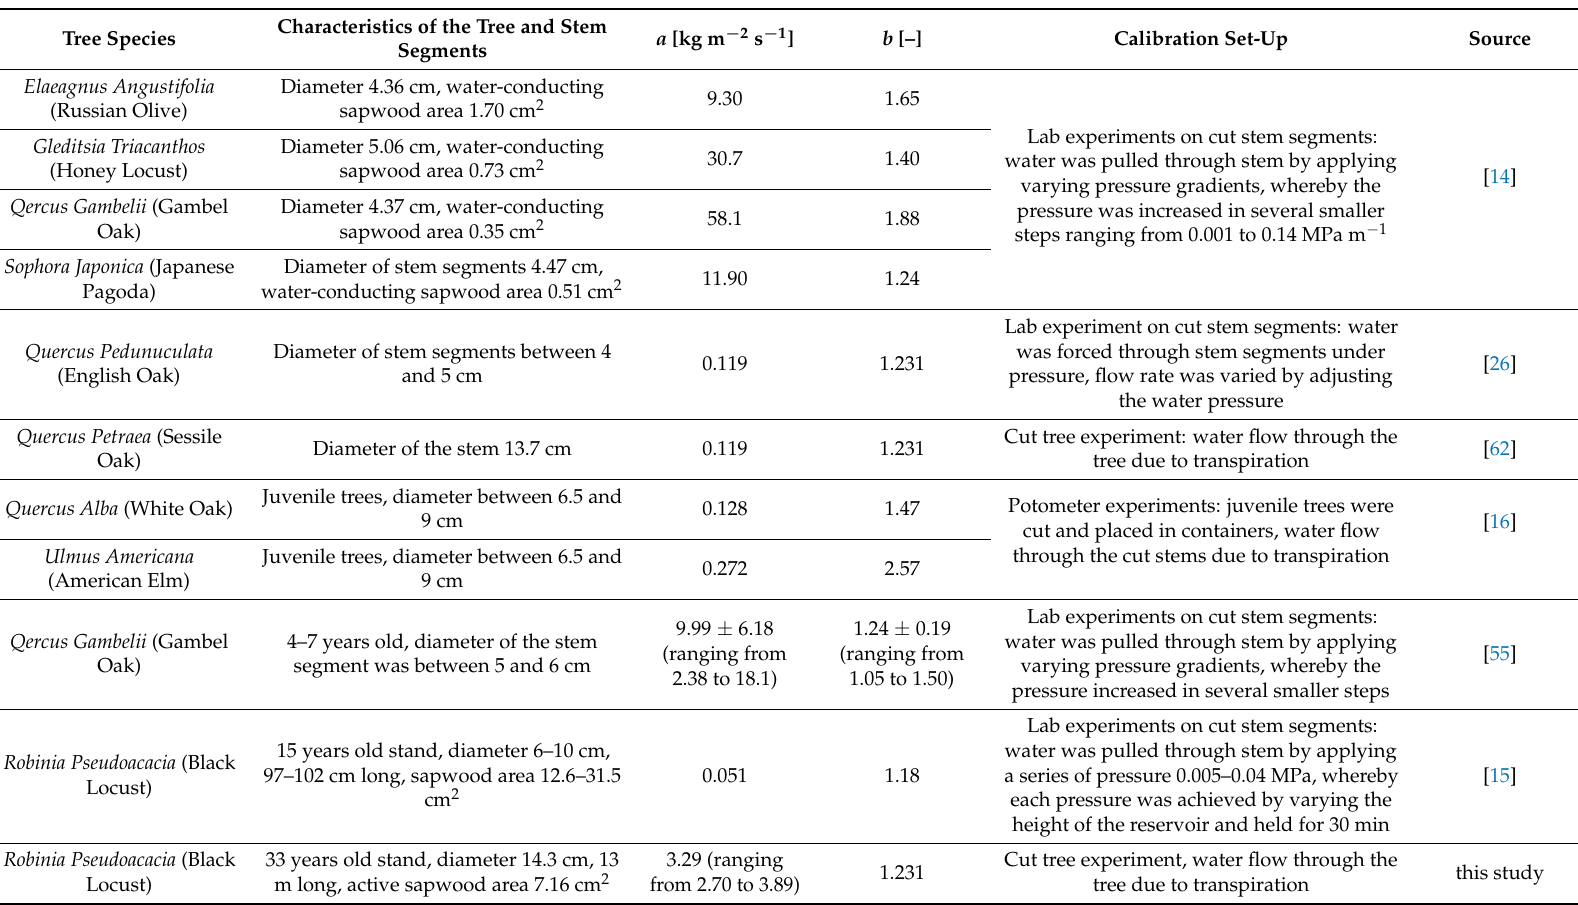
Table 2. Summary of the calibration of Granier’s sensors for different ring-porous tree species. The coefficients a and b are fitting parameters for converting the measured temperature differences into sap flow densities according to Equation